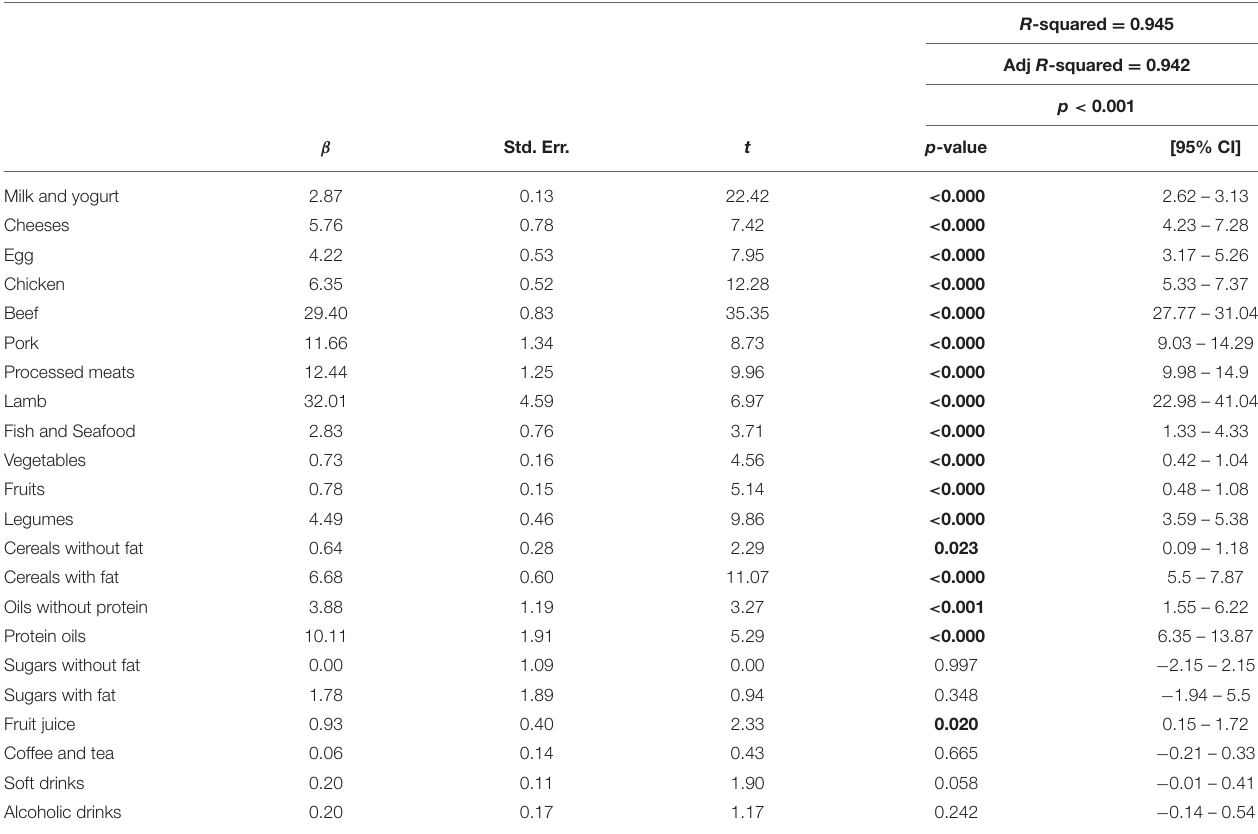
TABLE 4 | Multiple linear regression model between water footprint (WF) and dietary intake by food groups.